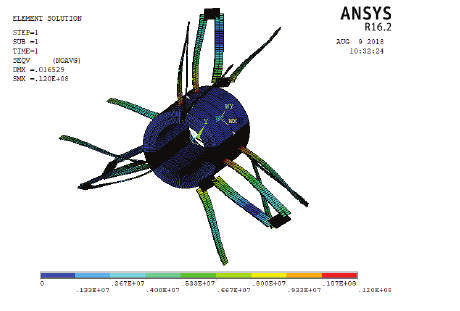
Figure 8. The stress and deformation of the hinge under the z -direction torque.